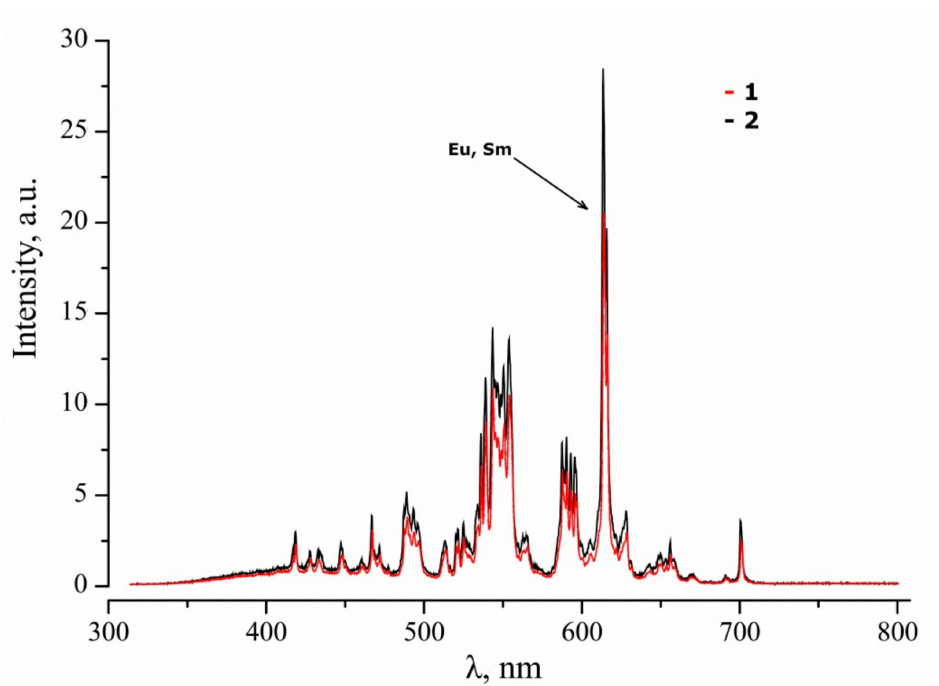
Figure 3. Cathodoluminescence spectra of Gd 0.96 Eu 0.01 Sm 0.01 Tb 0.01 Er 0.01 Nb 0.9 Ta. 0.1 O 4 sample 1 (1) before and (2) after vacuum